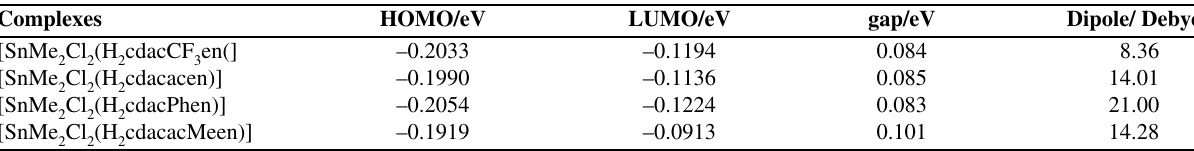
Table 8. The computed electronic properties of Sn(IV) complexes with B3LYP/LANL2DZ.